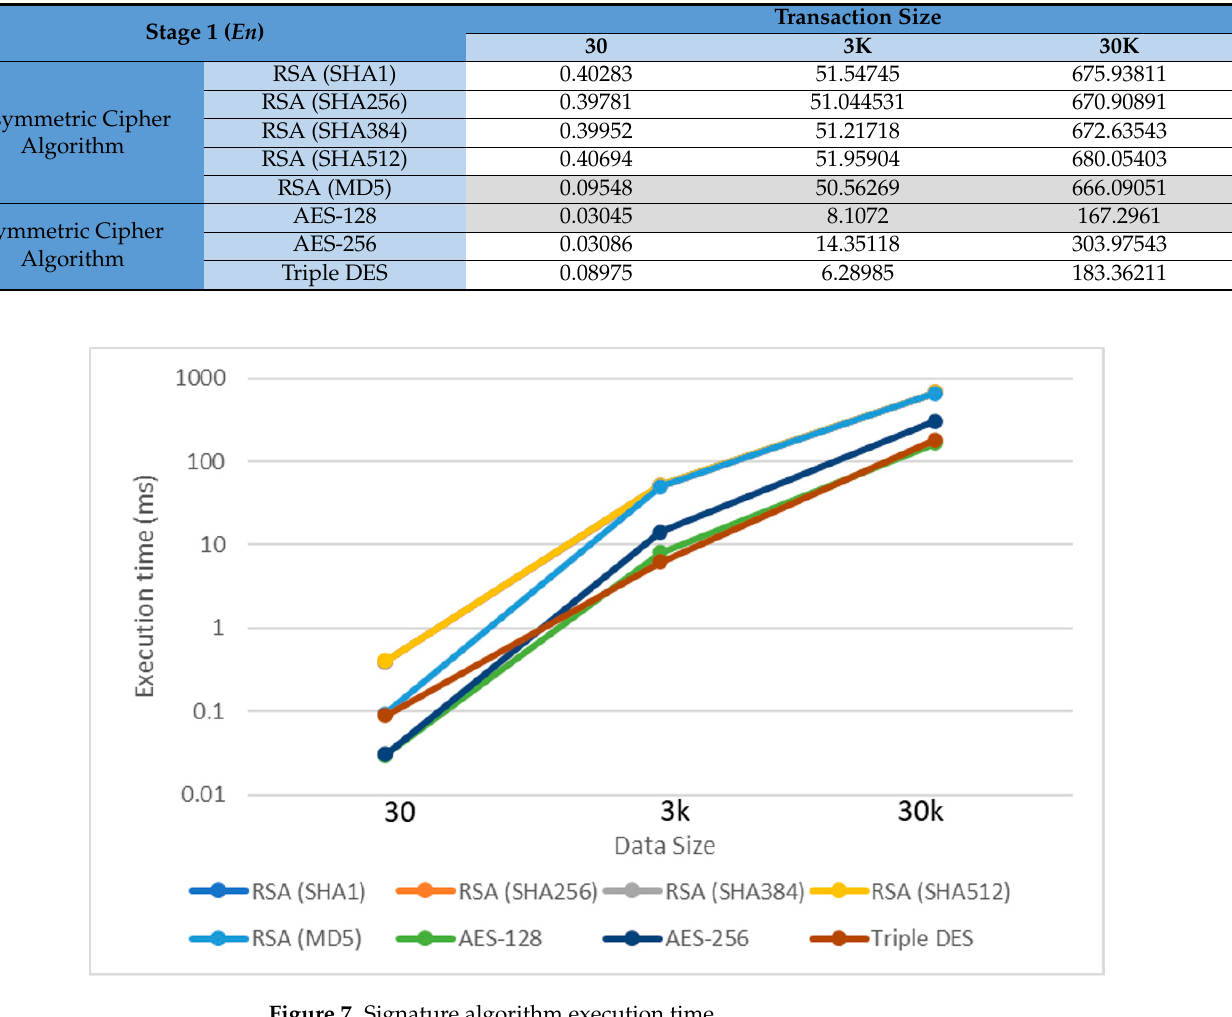
Table 2. Comparison of signature algorithm execution time in milliseconds.